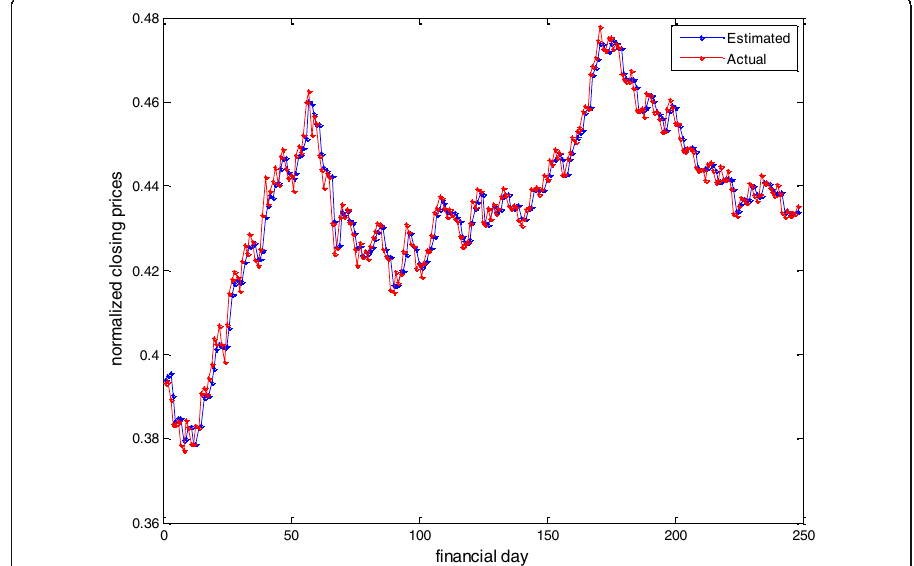
Fig. 8 Actual v/s estimated closing prices by CPNN-GA for NASDAQ indices